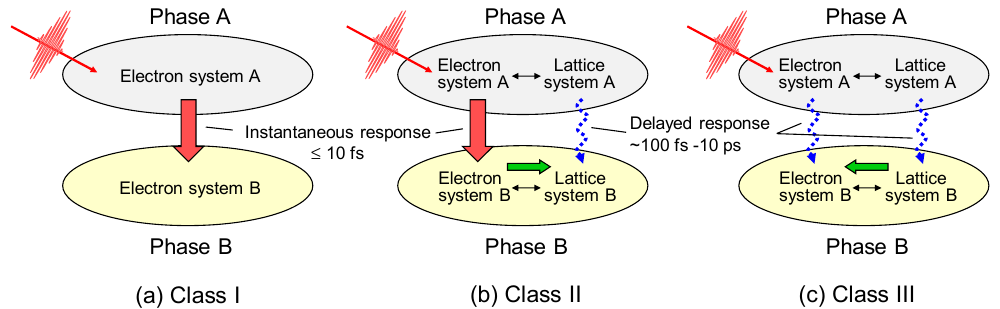
Figure 1. Classification of photoinduced phase transition dynamics from A phase to B phase. ( a ) Class I: